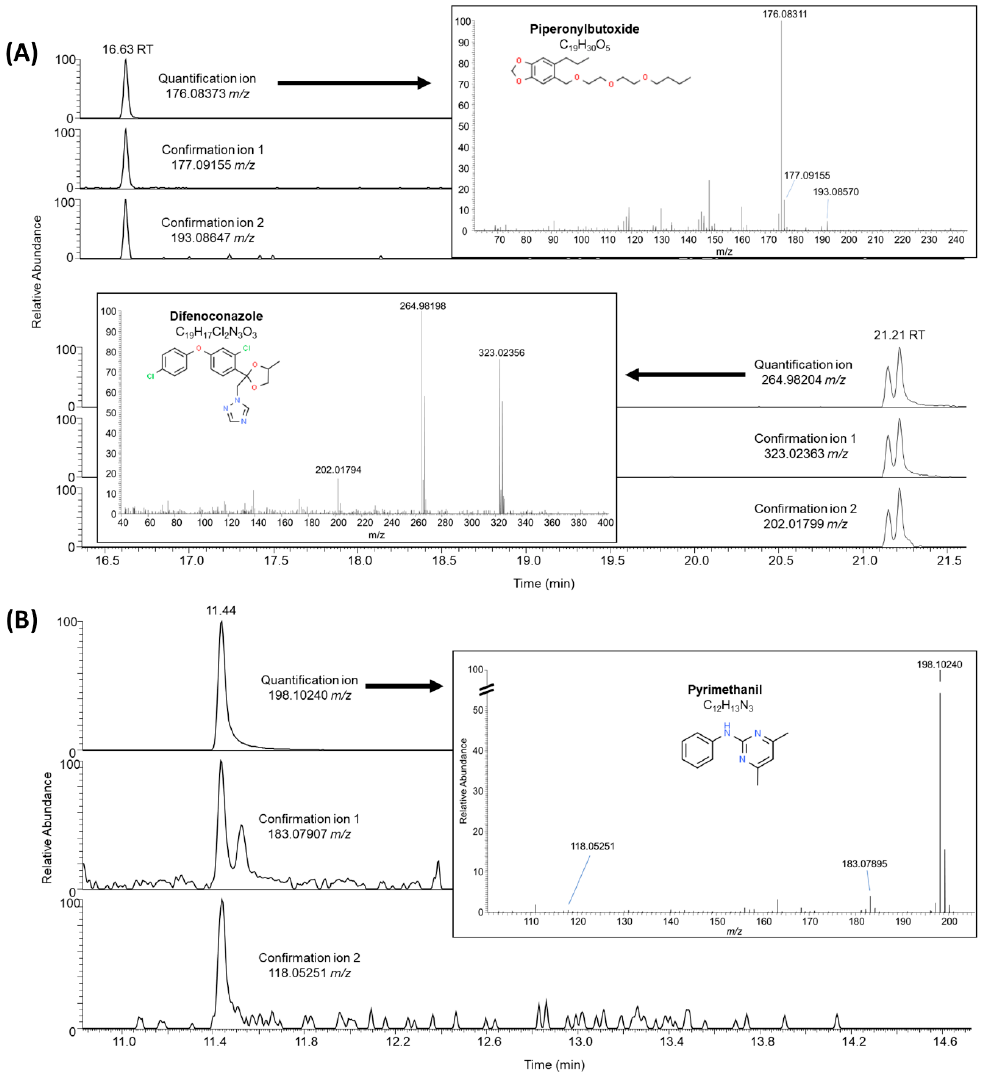
Figure 1. Extracted ion chromatograms and mass spectrum of some of the detected current-use pesticides: (A) piperonylbutoxide and difenoconazole in leaves at CG3, (B) pyrimethanil in the rhizome at station ALM3.